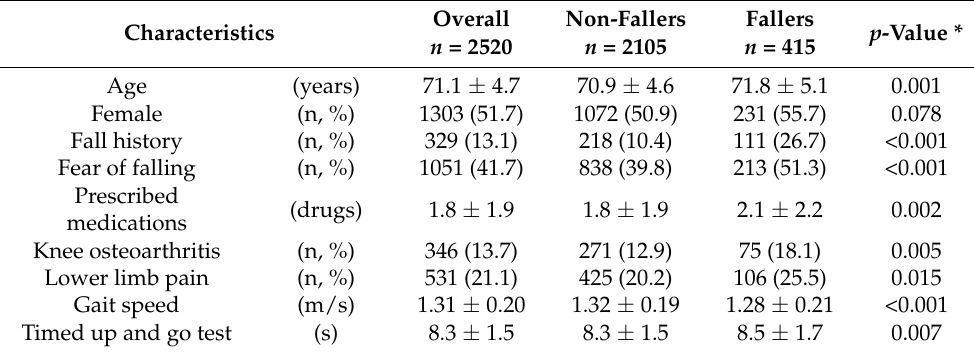
Table 1. Baseline characteristics according to fall status in the follow-up